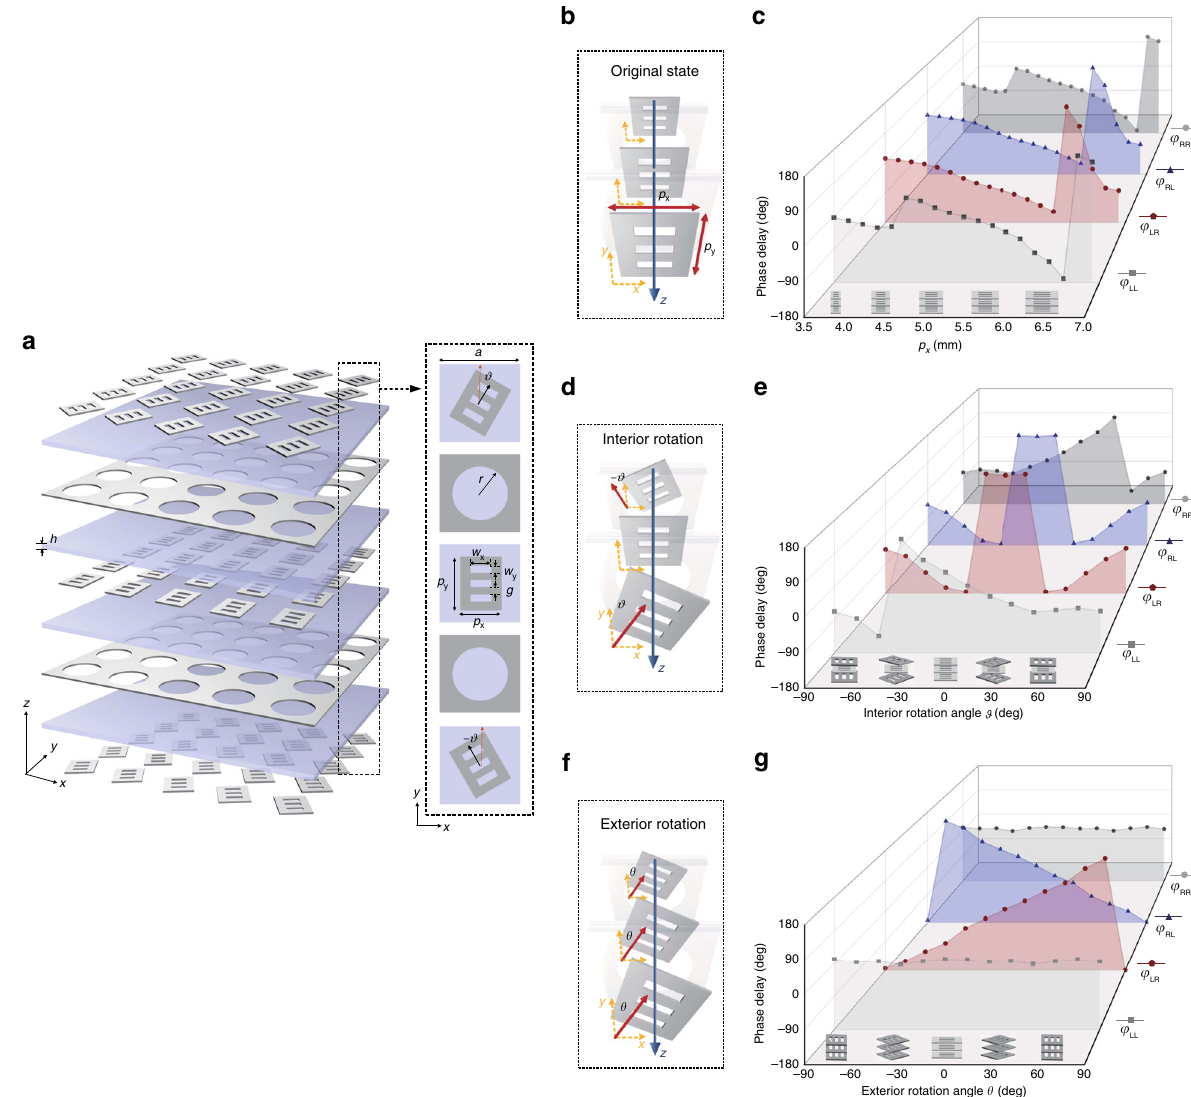
Fig. 2 Meta-atom design and veri fi cation. a Schematic of proposed meta-atom geometric structure, where periodicity is a = 8.8 mm, radius of circular aperture in the grid layer is r = 3 mm, thickness of each dielectric substrate is h = 1 mm, p x and p y are the length and width of metallic patch, w x and w y are the dimensions of rectangular gap in the metallic patch, g is the distance between two adjacent gaps, and ϑ is the interior rotation angle between three patch layers. b 3D view of meta-atom with original state and c the output phase pro fi les of four channels against length p x of the patch layer for verifying propagation phase. d 3D view of meta-atom with only interior rotation and e the output phase pro fi les of four channels against interior rotation angles for demonstrating chirality-assisted phase. f 3D view of meta-atom with only exterior rotation and g the output phase pro fi les of four channels against exterior rotation angles for demonstrating geometric